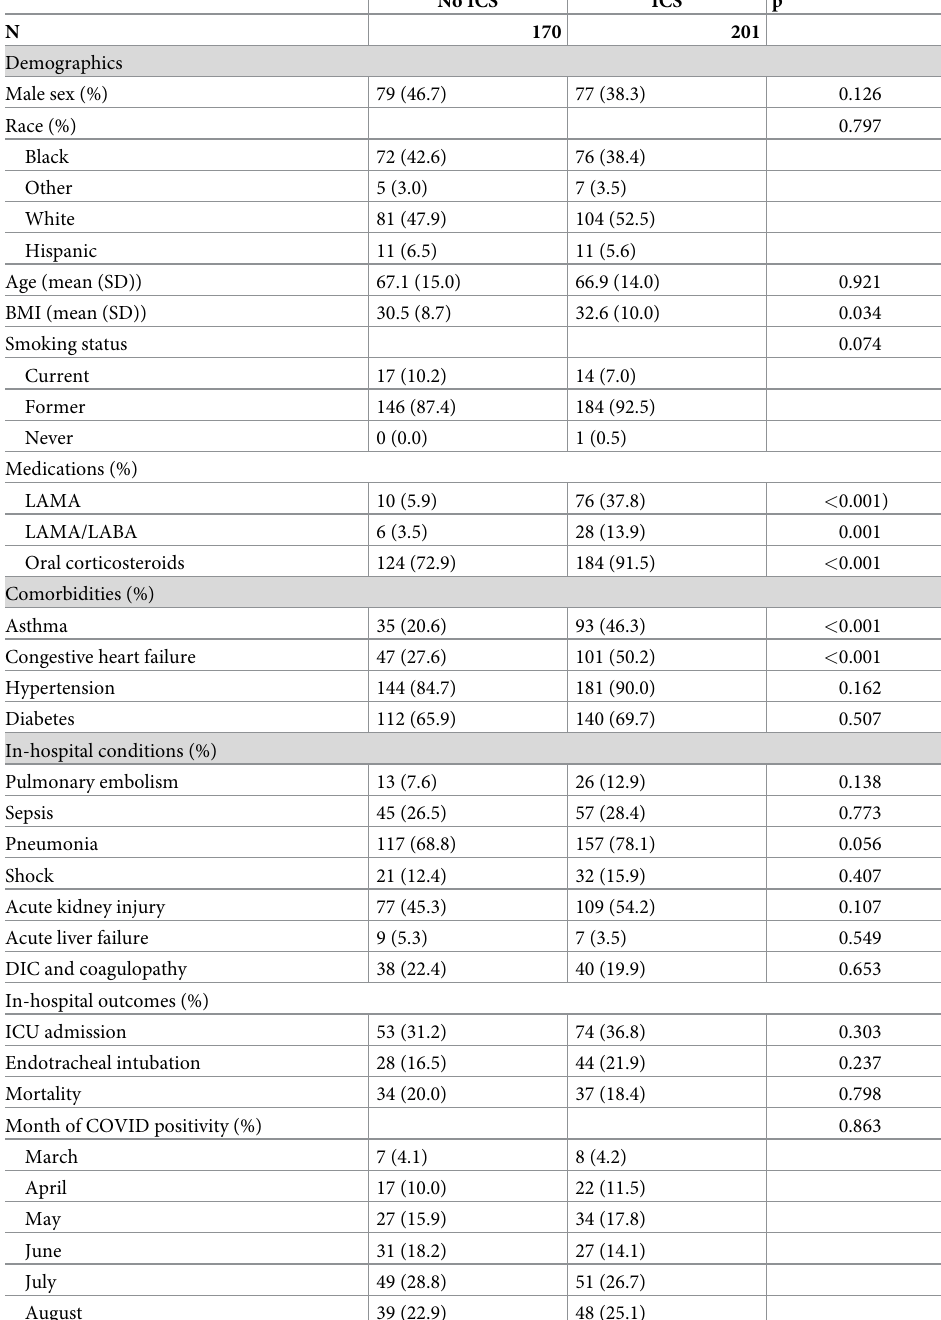
Table 3. Clinical characteristics and outcomes of hospitalized patients with COPD who tested positive for COVID-19 categorized by ICS